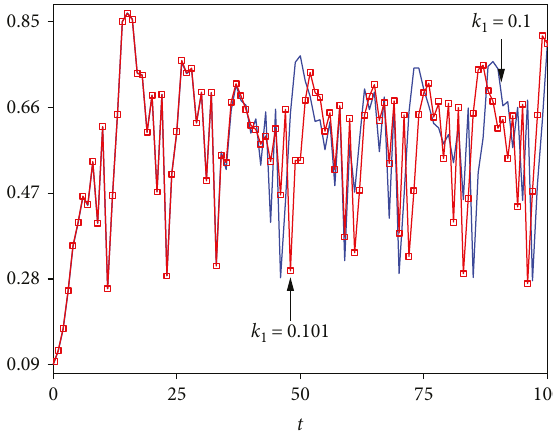
Figure 19: Time series of k